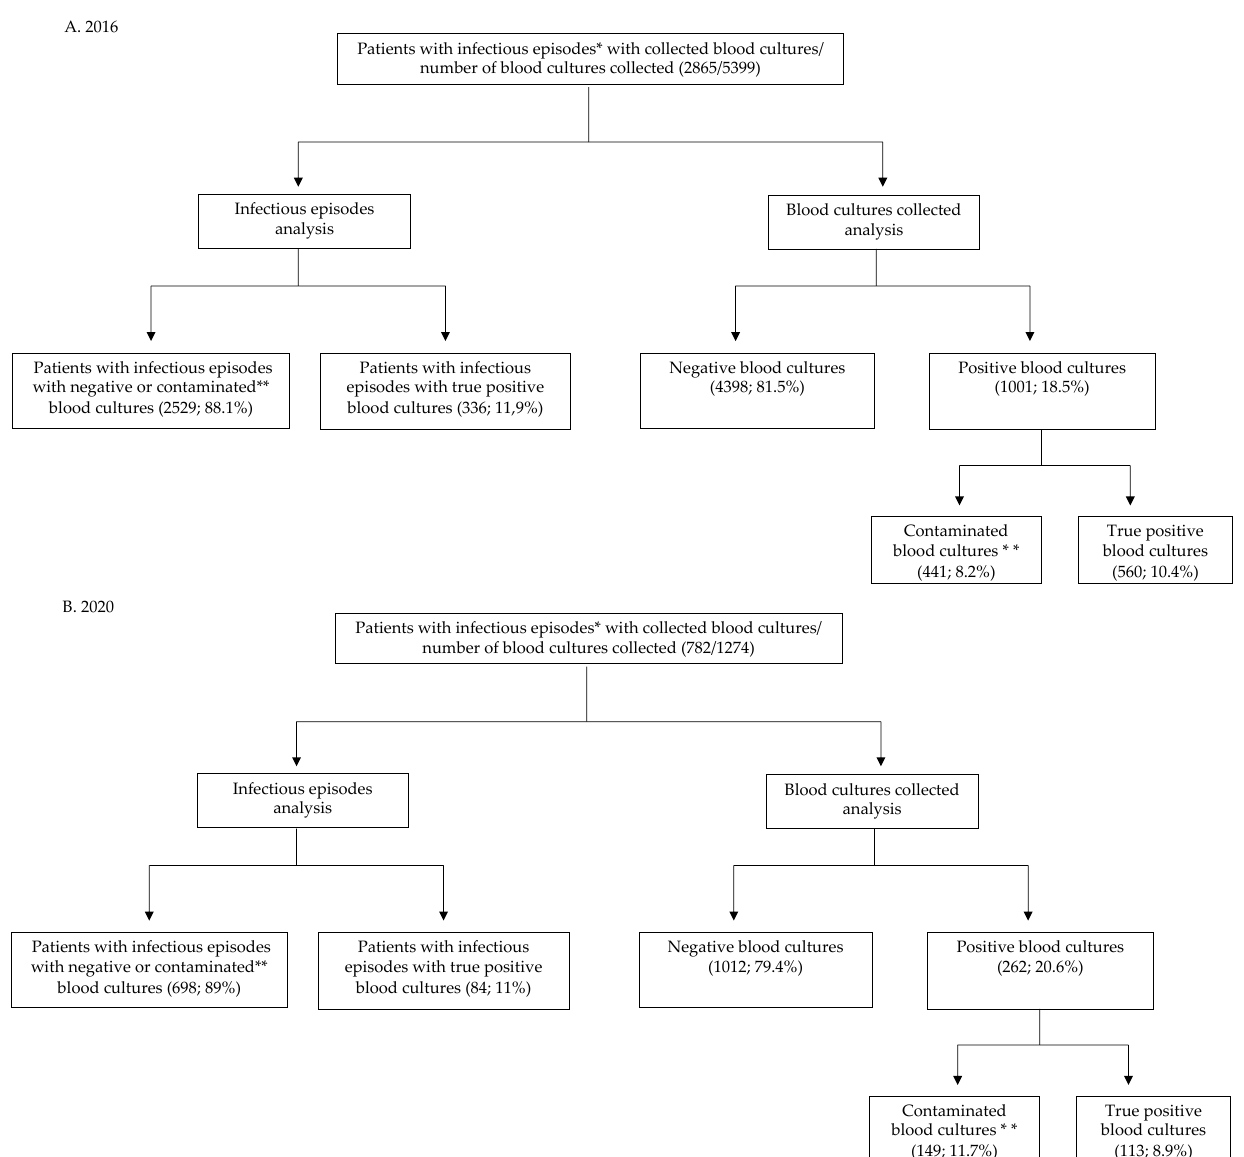
Figure 1. Distribution of patients into groups related to the blood culture results: ( A ) (2016) and ( B )